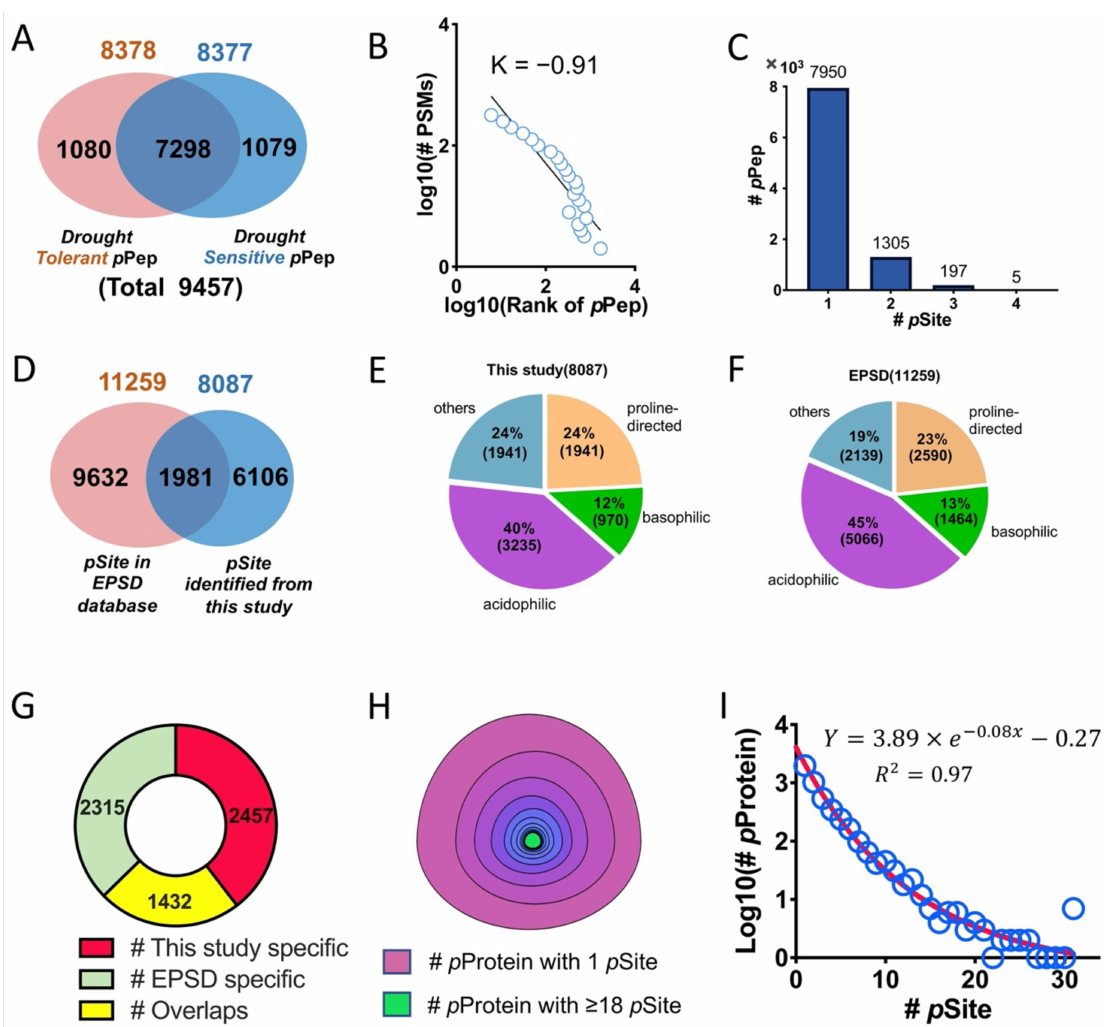
Figure 1. Phosphoproteomic analysis of the drought-treated soybean plants. ( A ) A Venn diagram shows the numbers of non-redundant, repeatable, and label-independent phosphopeptides (9457) of both drought-tolerant (8378) and -sensitive cultivars (8377, Supplementary Table S2d, Figure S4A). B ) Distribution of the PSM numbers of each soybean